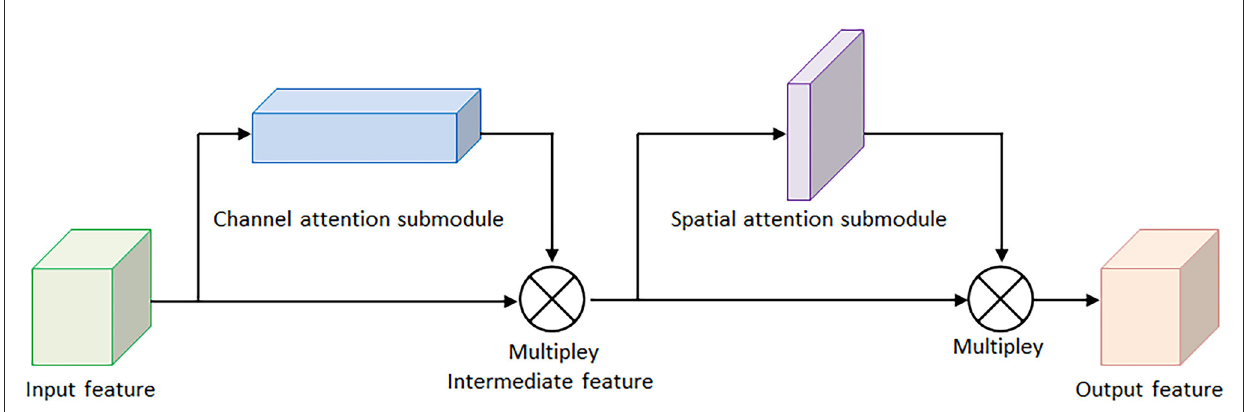
FIGURE4 The architecture of convolutional block attention